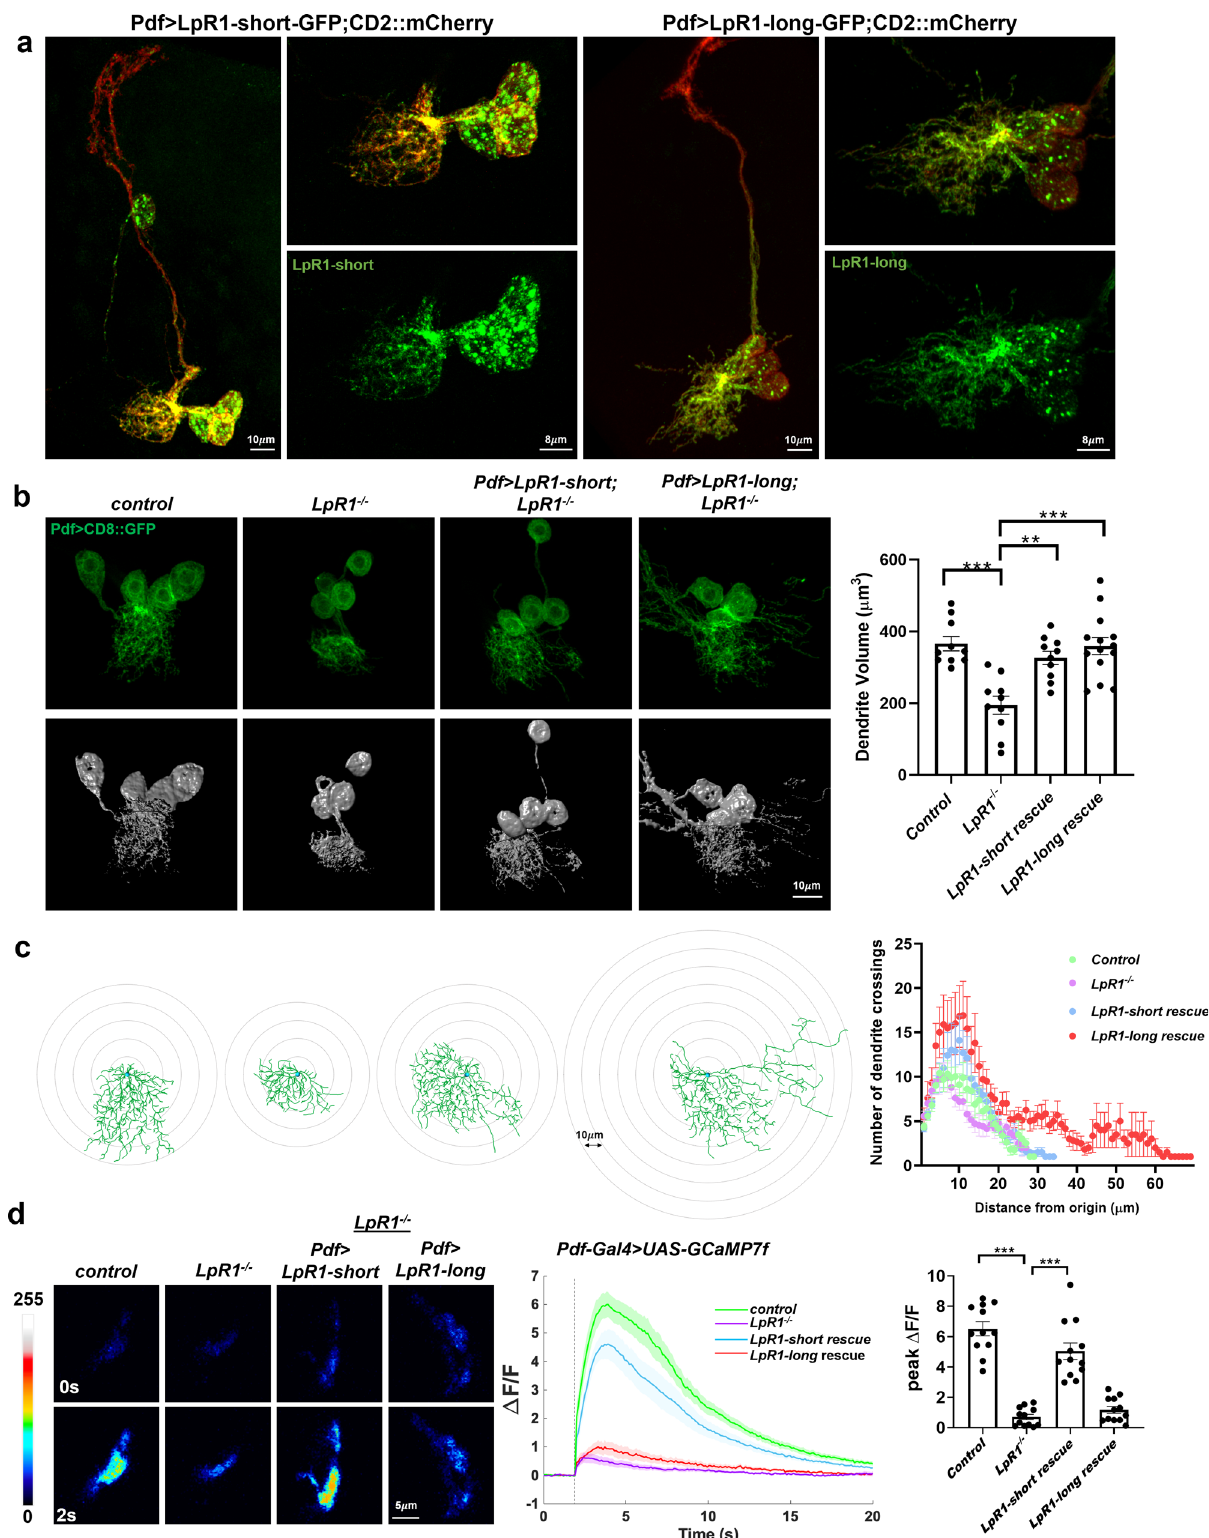
fi ndings in Drosophila peripheral tissues, where long-isoforms of LpR1 recruit lipids through an endocytosis-independent mechan- ism and LTP-facilitated cell surface lipolysis 33,47 and demonstrate the functional signi fi cance of isoform-speci fi c tissue distributions of the LpR1